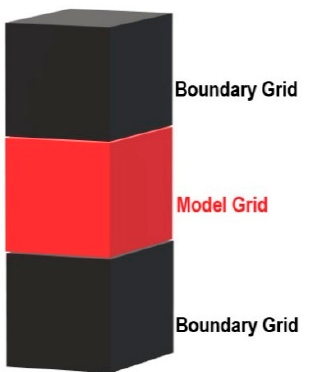
Figure 3. Schematic diagram of CO 2 -formation water-rock numerical simulation.